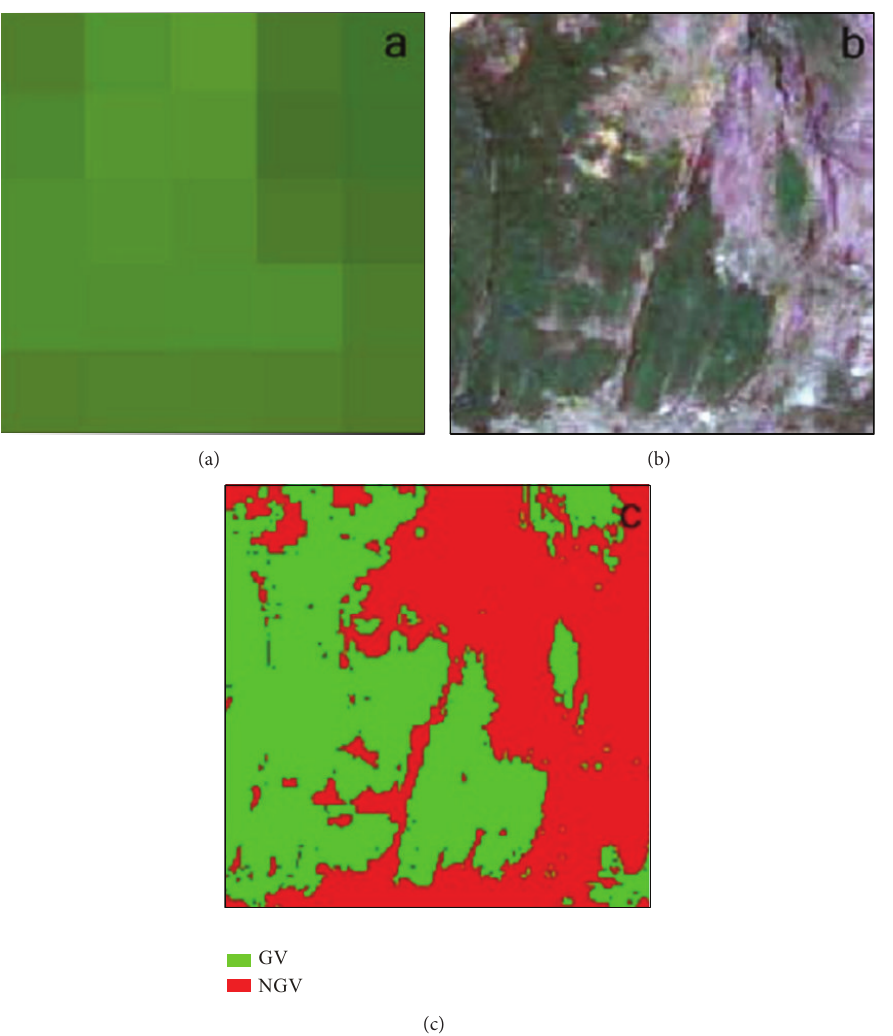
Figure 4: The estimation of actual fractional green vegetation cover (FV) with the 5 × 5 window surrounding each sample TM pixel from the high resolution image. (a) is the 5 × 5 pixel of TM subset with 5-4-1 band combination; (b) is the high resolution subset corresponding to the 5 × 5 pixel; (c) is the classified results of the high resolution subset. GV is the abbreviation for green vegetation, and NGV represents no green